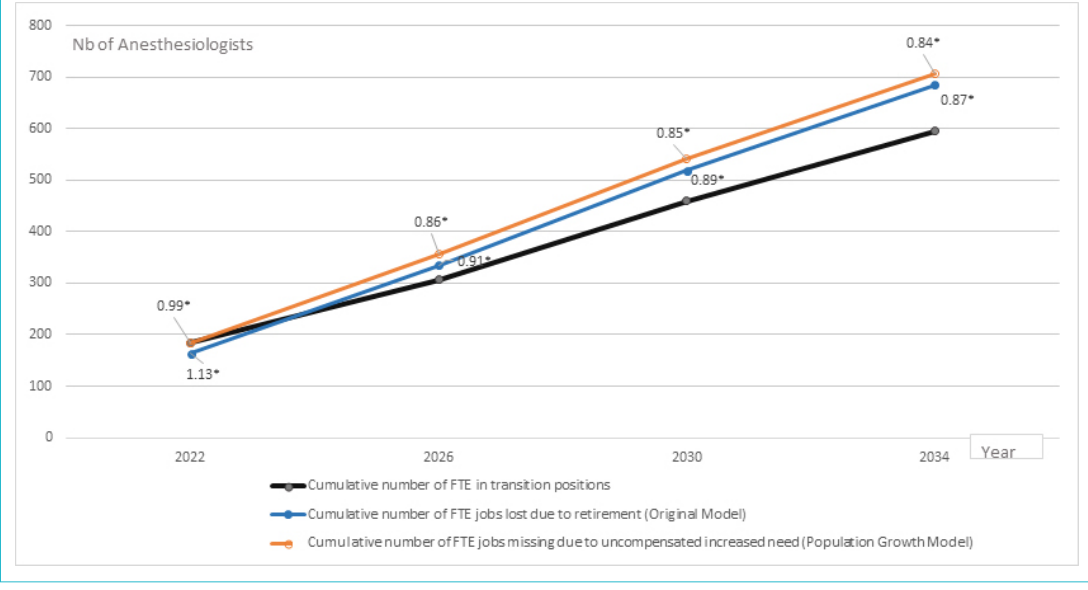
Figure 4: Cumulative change over time in the number of full-time equivalent (FTE) fixed positions according to original and increased popula- tion scenarios. * Ratio of FTE transition positions / FTE jobs lost due to retirement or missing due to uncompensated increased need following population growth [stability =1].